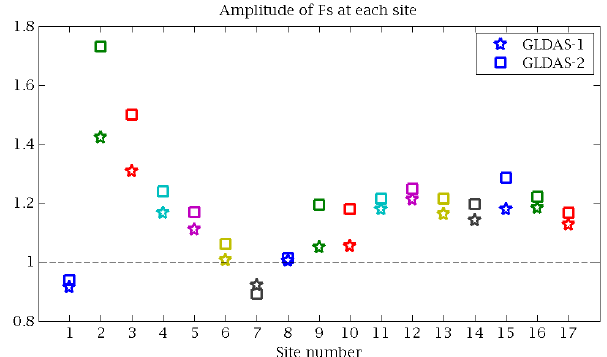
Figure 9. Amplitude of F s = p h /m h as derived from GLDAS-1 and GLDAS-2.0 for each